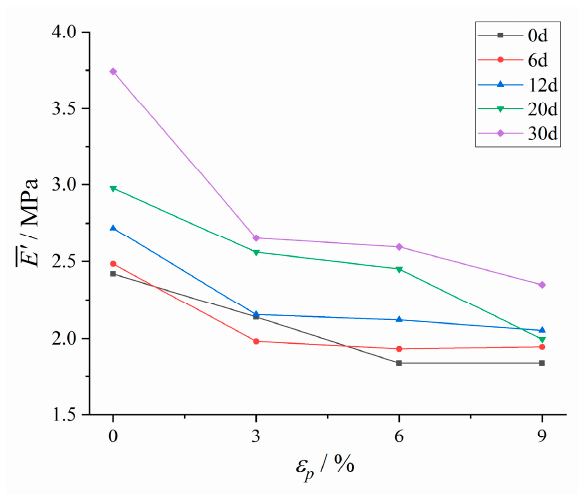
Figure 13. The changing curves of the di ff erence of storage modulus with pre ‐ strain.